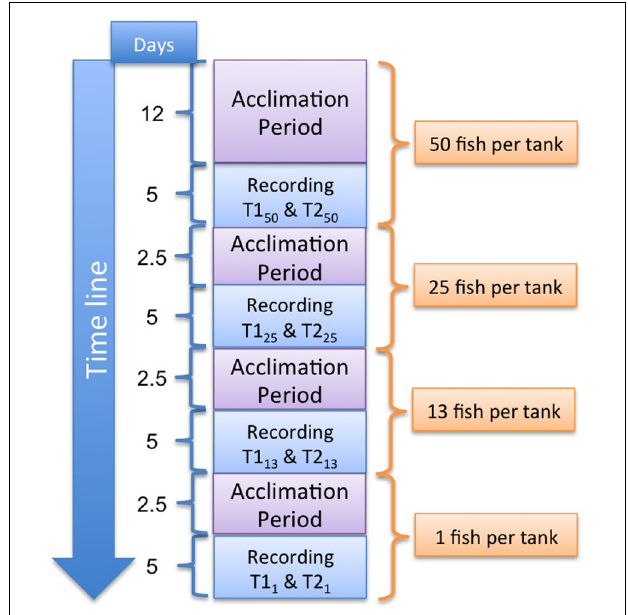
FIGURE 1 | Description of Experiment A. The fish number is halved in each step except the last one, when it was reduced from 5 to 1 individual. T1 and T2 indicate tank 1 and 2, respectively, and the sub-index the number of fish. The number of days the activities lasted is shown under “Days” on the left.